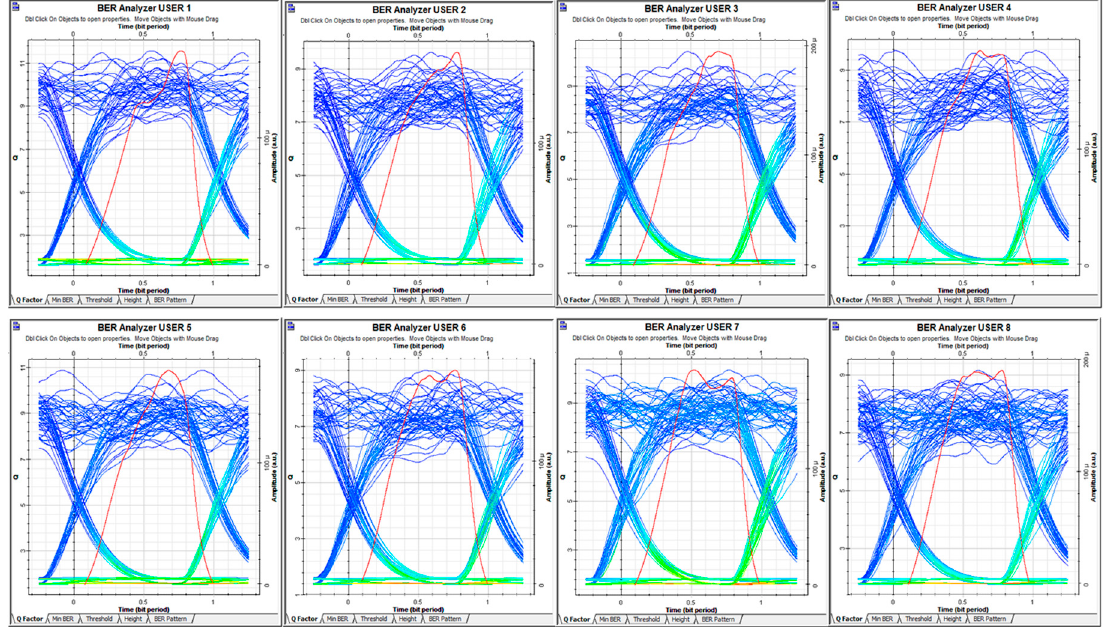
Figure 16. Eye diagrams of eight 3D-VWZCC users.